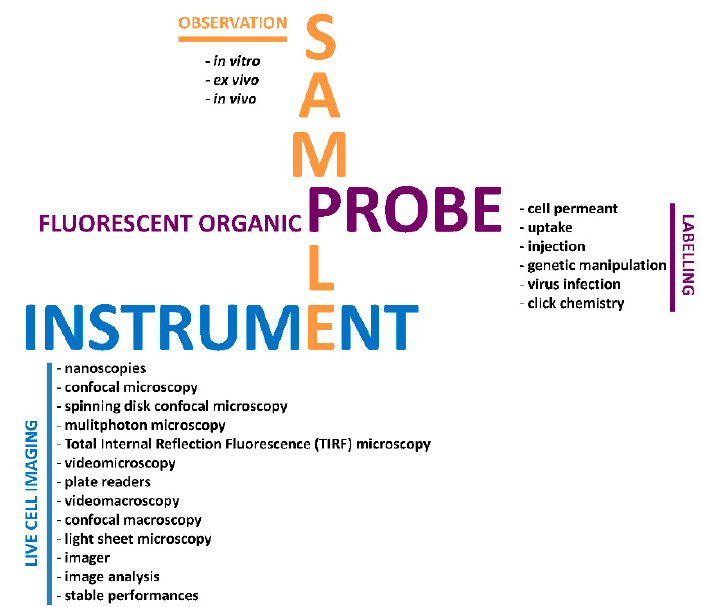
Figure 1. Representation of the “Probe–Sample–Instrument” (PSI) triad. Interrelation between the three essential key elements for successful live cell imaging. Type of sample observation, strategies for fluorescent cell labeling, and diversity of live cell imaging instruments are listed.